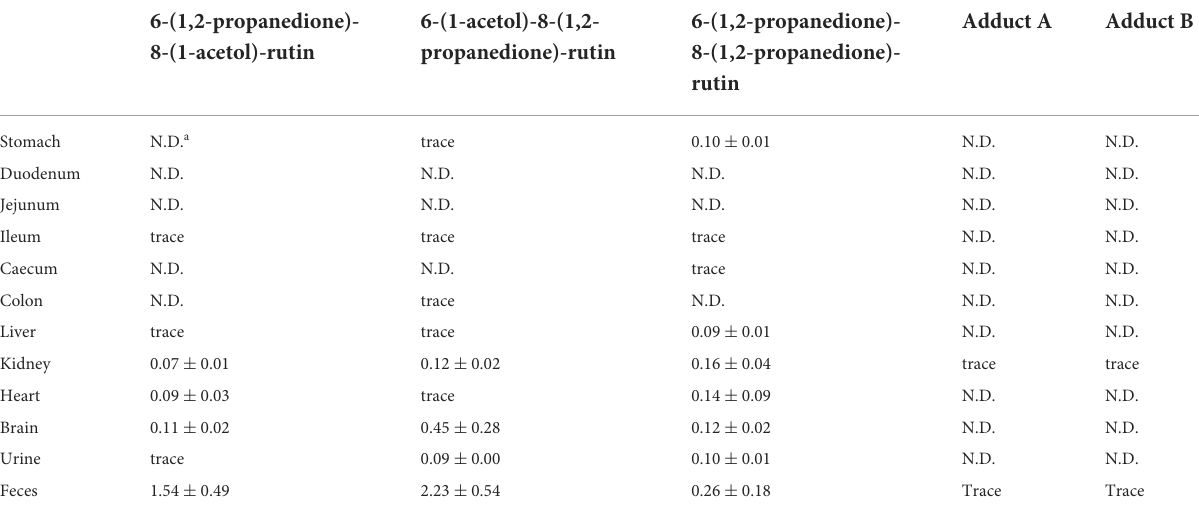
TABLE 4 Concentrations of rutin-MGO adducts in tissues, urine, and feces of rats after 24h of rutin administration (100 mg/kg BW). Tissue